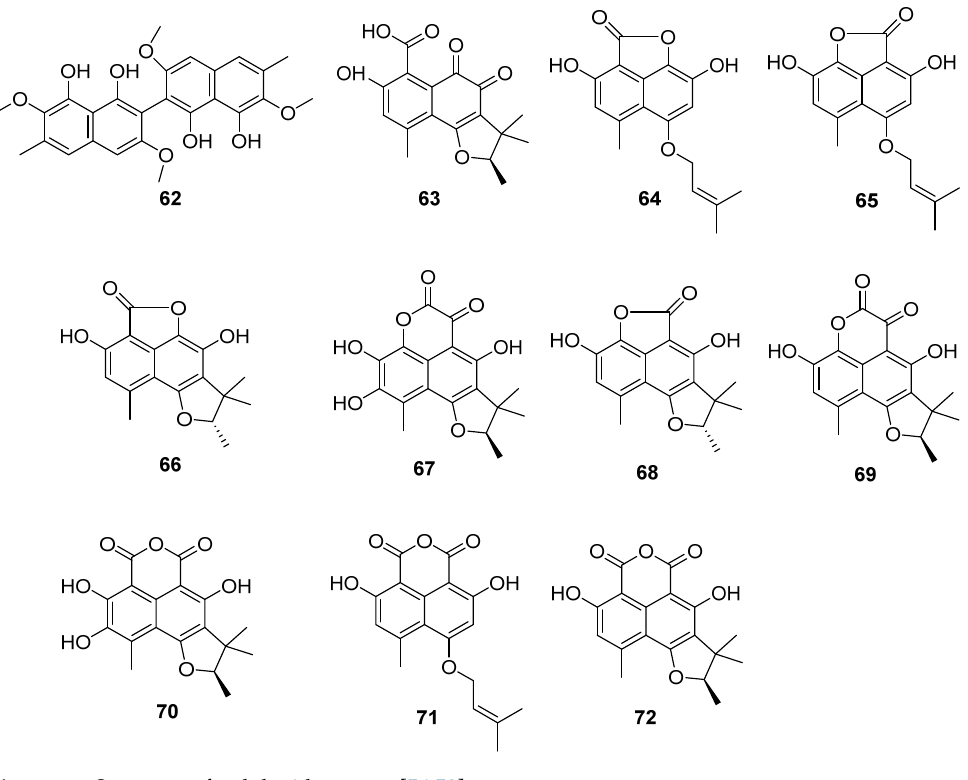
Figure 12. Structure of polyketides 62 – 72 [56,59].